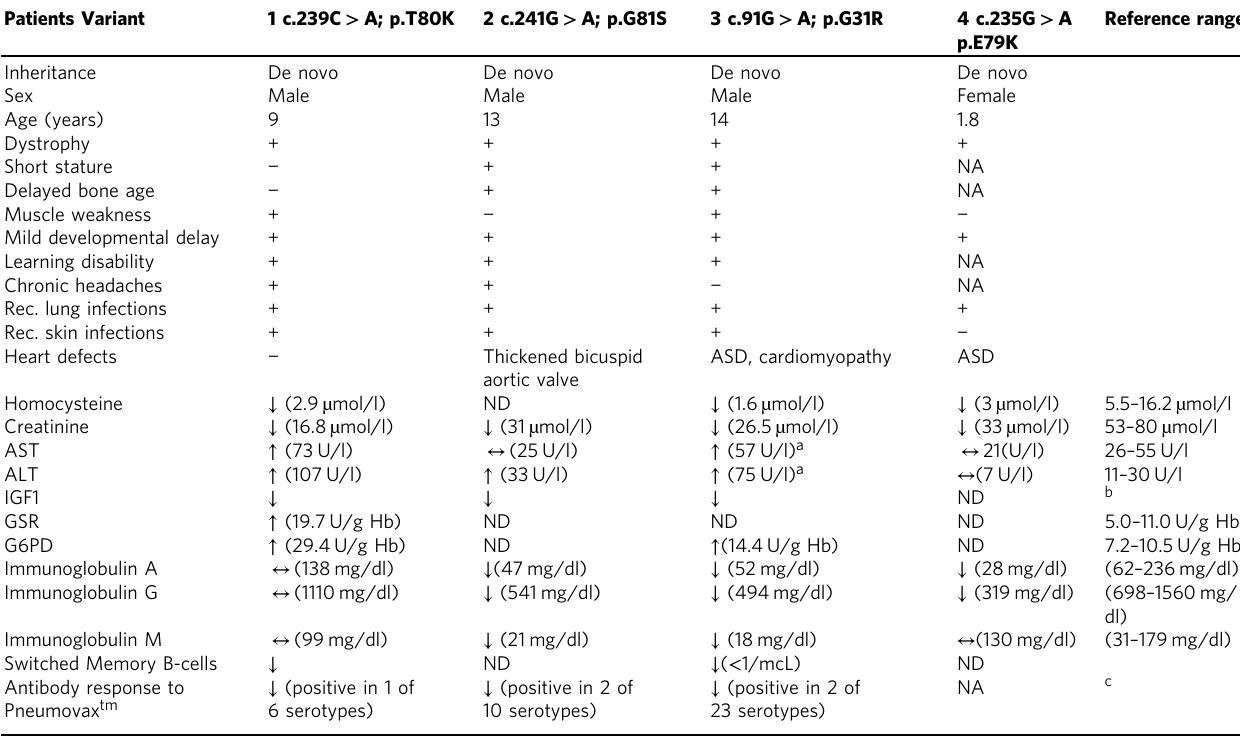
Table 1 Summary of clinical features of patients harboring NFE2L2 mutations Patients